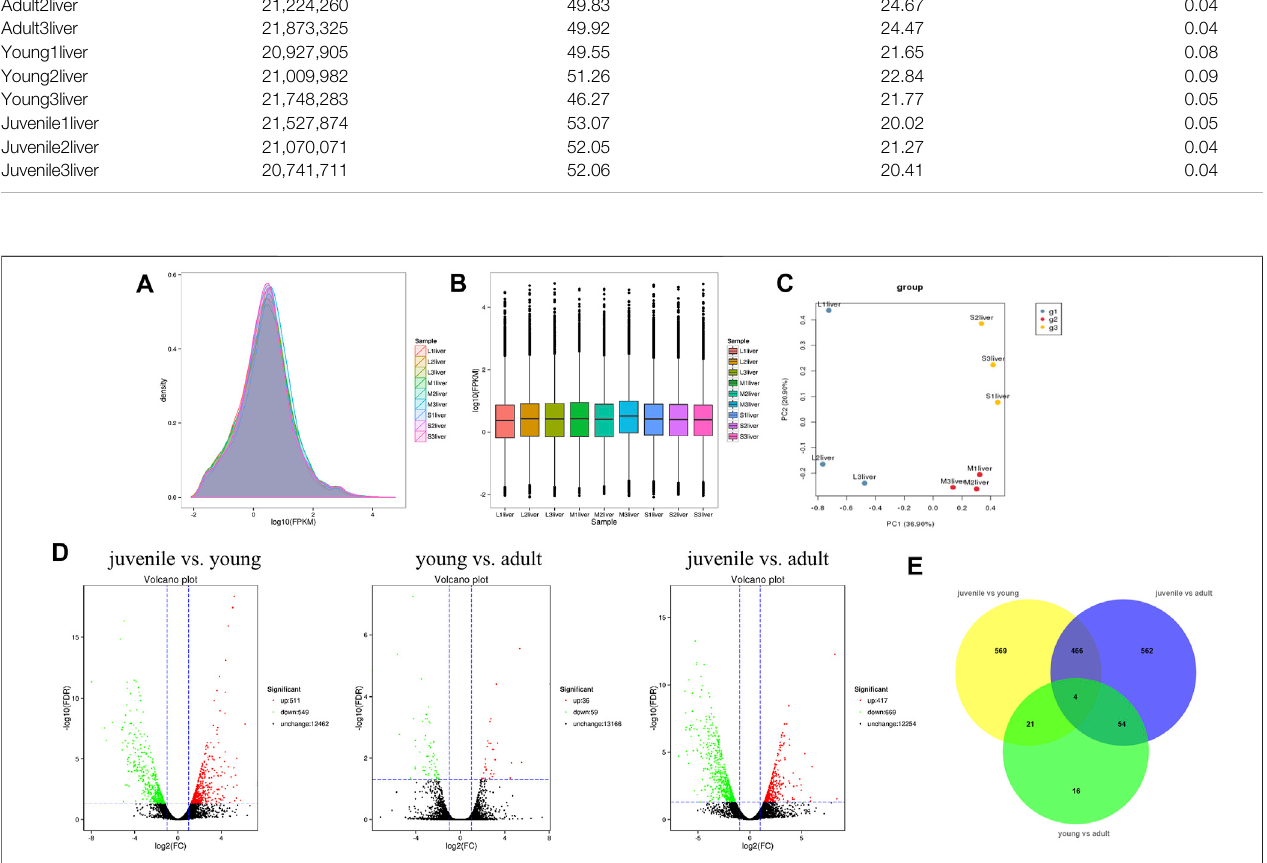
FIGURE1| Qualityassessmentandanalysisofglobalgeneexpressionamongliversamplesatthreestages. (A) IntuitivedisplaygenesexpressedatdifferentFPKM levels. (B) Boxplot of FPKM distribution among liver samples. (C) Principal component analysis (PCA) plots of all transprits at dif fi erent stages in S. prenanti. (D) Volcano plotofdifferentialexpression genesamongthethreestagesinthepairwisecomparisons. (E) VenndiagramshowingthenumberofDEGsintranscriptabundanceinliver of S. prenanti . Yellow circles indicate the samples of juvenile vs young, green circles indicate the samples of young vs adult, and blue circles indicate samples of juvenile vs